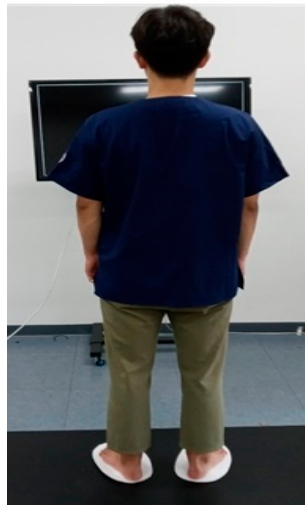
Figure 1. Intervention of saccadic eye movement.